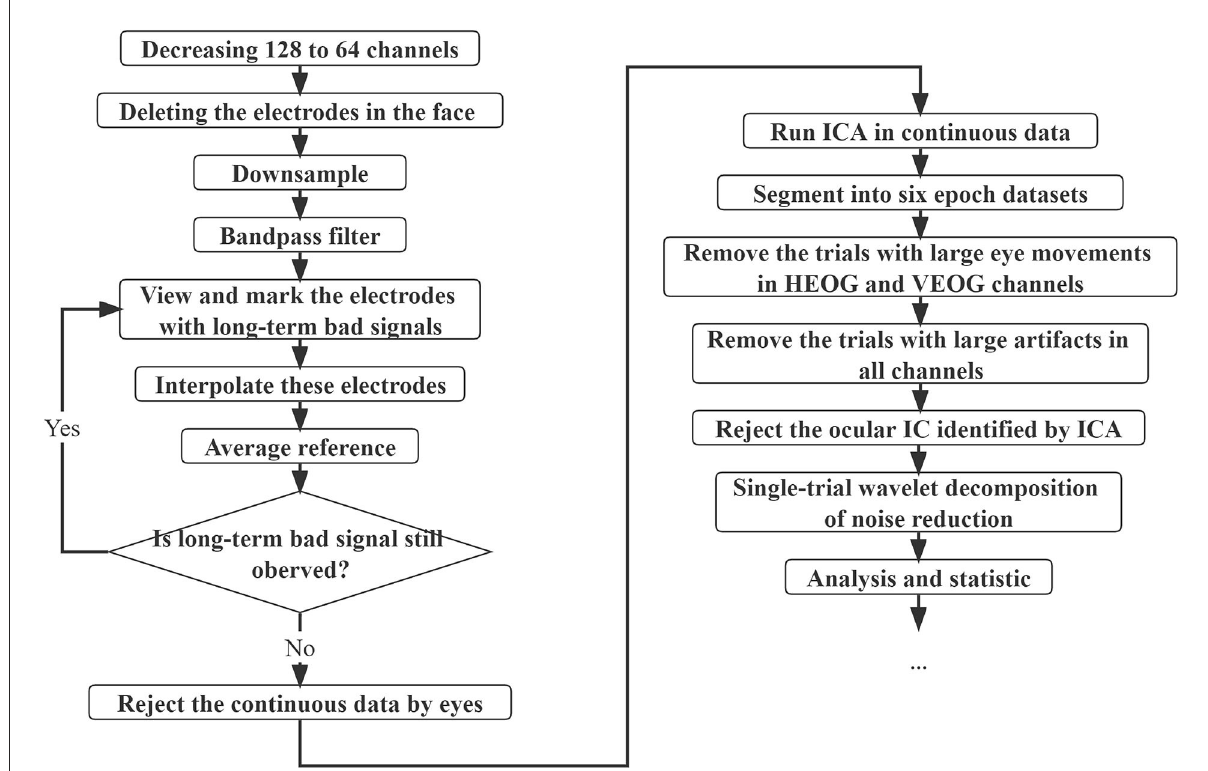
FIGURE2 Flowchart of the entire pre-processing procedure. The data were decreased from 128 to 64 channels if collected with the 128-channel system. Then, four electrodes in the face were deleted. The data were downsampled at 250Hz, and the bandpass was filtered at 1–30Hz. After interpolating all the electrodes with long-term bad signals, the data were average re-referenced. After visually inspected to remove artifacts, the independent component analysis (ICA) was conducted on the continuous EEG data. Then, the continuous time series were segmented into six epoch datasets from − 200 to 400ms relative to stimulus onset with baseline correction ( − 200 to 0ms). The trials with large eye movements and large artifacts were removed. For the remaining trials, the ocular ICs identified by ICA were rejected, and then single-trial wavelet decomposition was used to reduce noise.